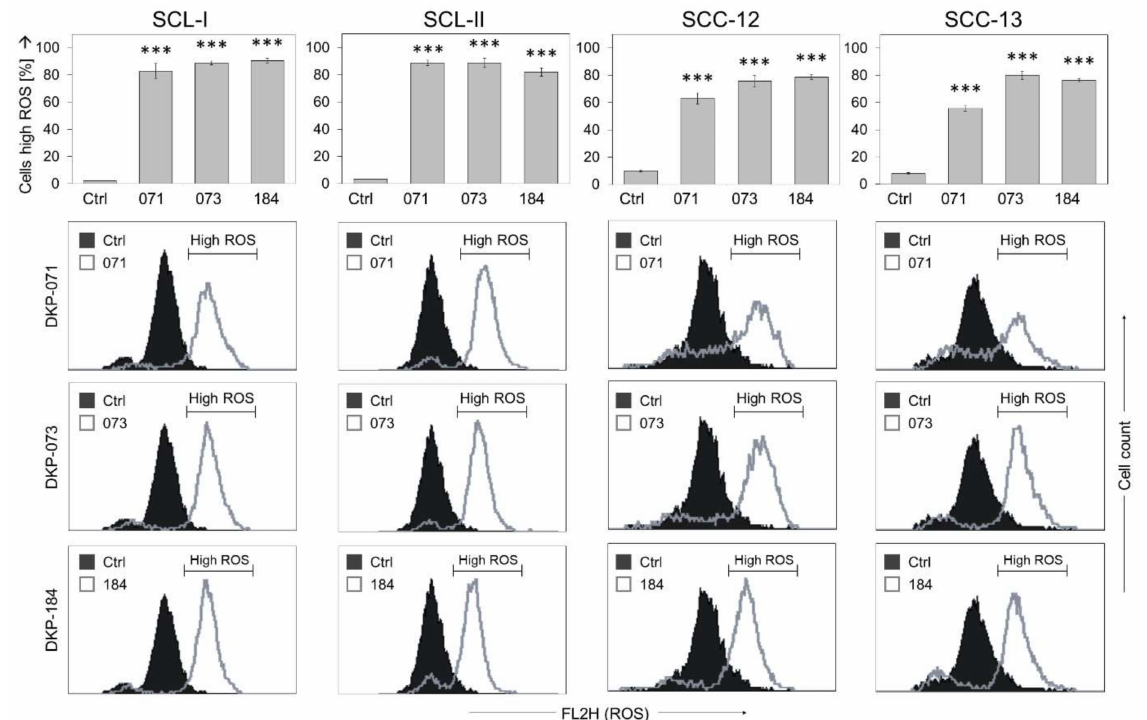
Figure 3. Changes in ROS production. ROS levels were determined by H 2 DCF-DA staining in four cSCC cell lines at 4 h of treatment with indirubins (DKP-071, -073 and -184, 10 µ M). Example cytometry measurements of controls and treatments are provided below (overlays of treated cells vs. controls), and cell fractions with high ROS are indicated. Mean values and SDs are shown of a representative experiment (two independent experiments, each one with triplicates). Asterisks (***) indicate high statistical significance, as compared to controls ( p <